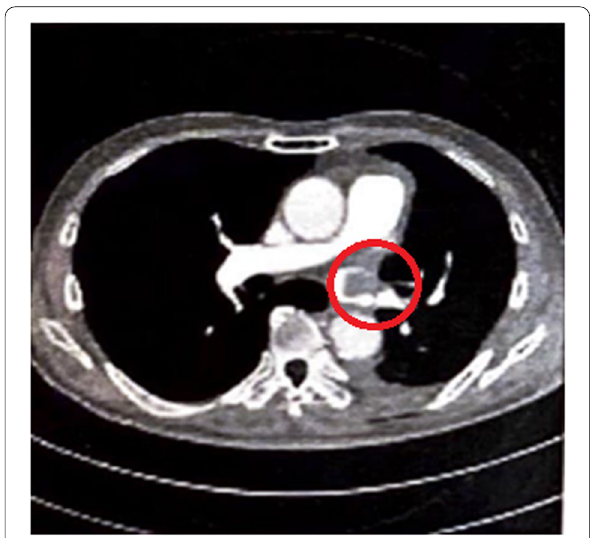
Fig. 1 Contrast-enhanced chest computed tomography image. The circle indicates the pulmonary vein